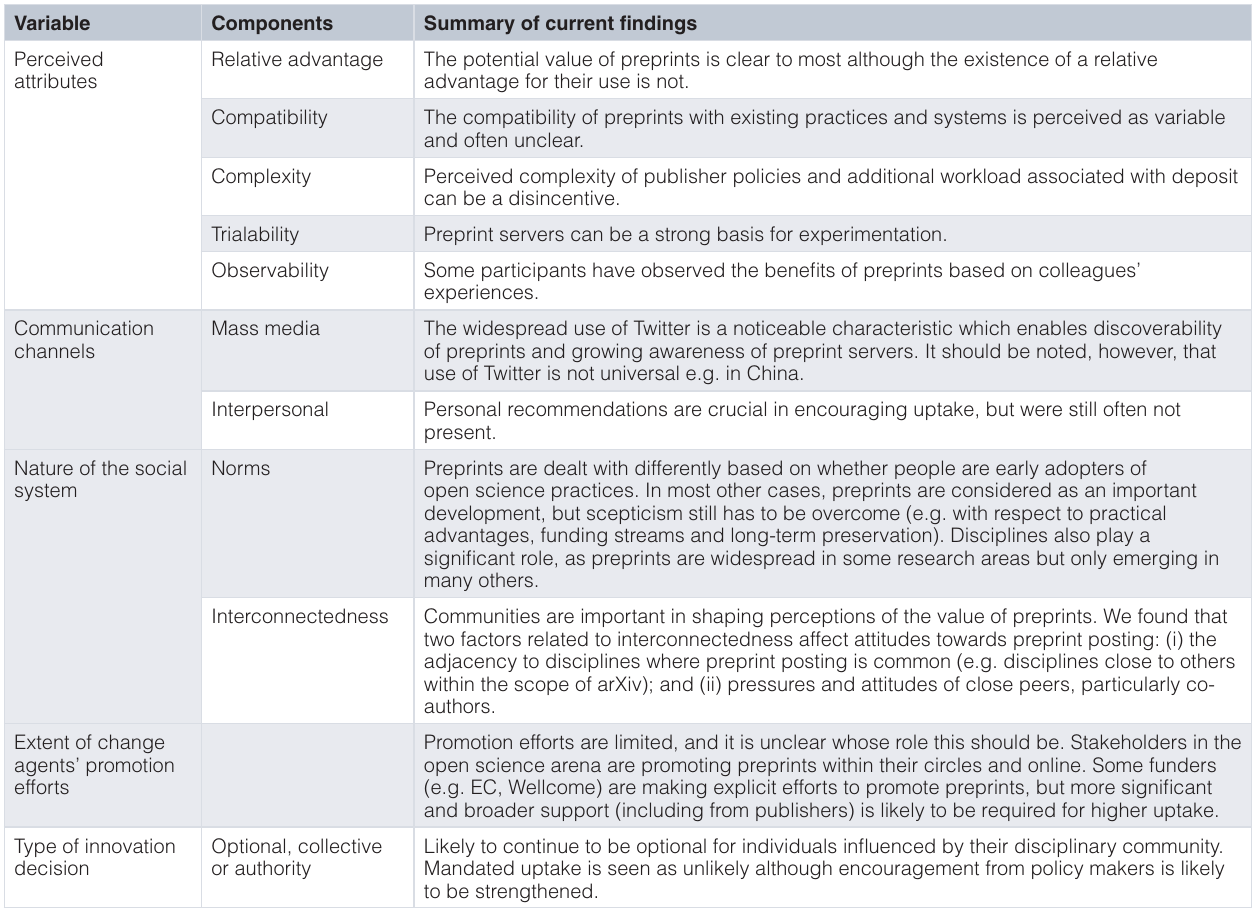
Table 8. Findings in relation to the rate of innovation adoption from innovation diffusion